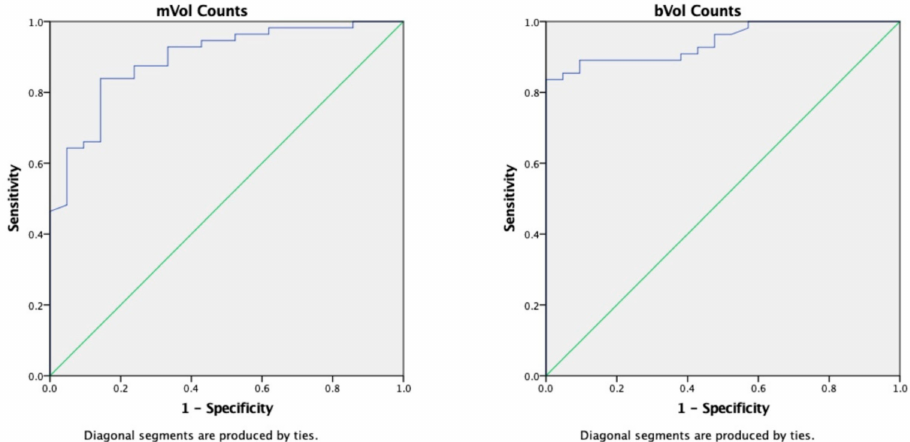
Figure 4. Receiver operating characteristics (ROC) curve of metastases volume (M Vol ) and trabecular bone volume (B Vol ) counts / voxel values according to progression. Radioactivity concentration was able to discriminate patients with a progressive disease in M Vol as well as in B Vol